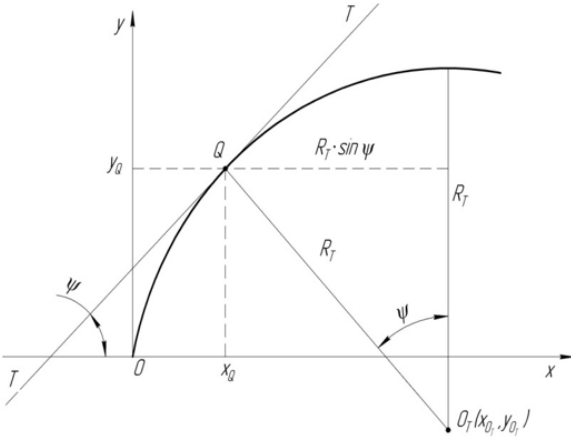
Fig. 3. Derivation of function of theoretical path of wheeled vehicle steered wheels at certain time t = t Q reach maximum angles and the vehicle is at the segment of steady motion along the path with constant curvature radius R T